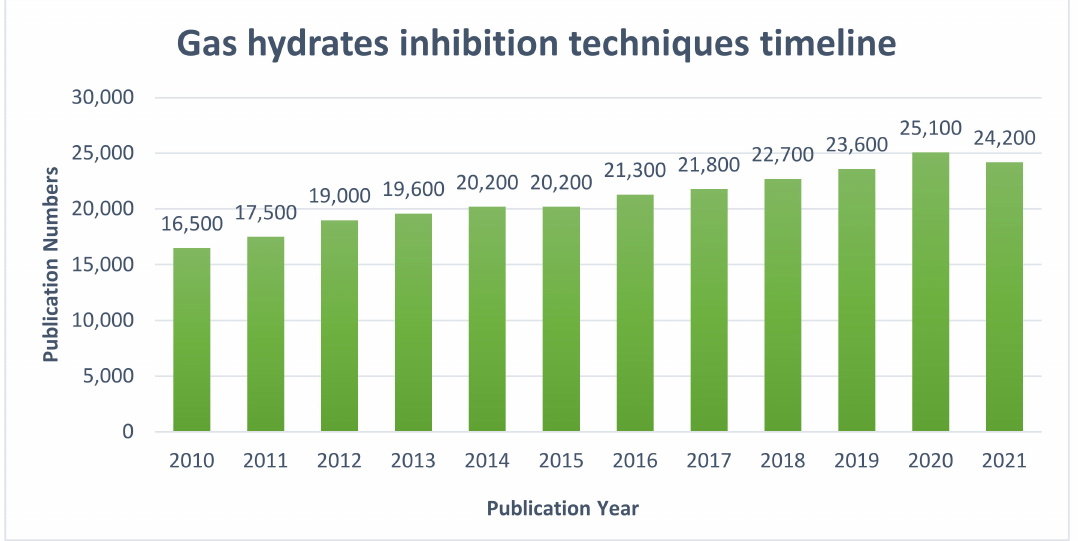
Figure 1. A short post-2010 gas hydrate inhibition techniques timeline representing the number of techniques proposed in hydrate inhibition-related academic publications (Source: Google